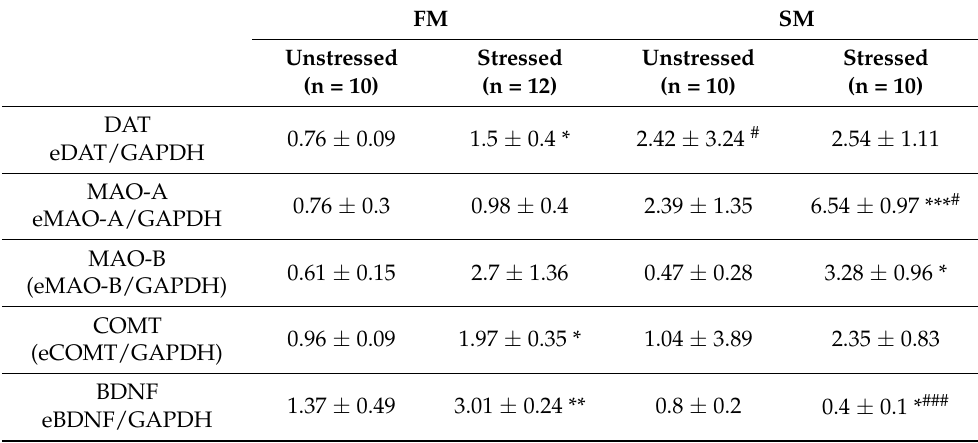
Table 2. Gene expression of hippocampal metabolic enzymes and BDNF in FMs and SMs. FM SM Unstressed Stressed Unstressed Stressed (n = 10) (n = 12) (n = 10) (n = 10) DAT 0.76 ± 0.09 1.5 ± 0.4 * 2.42 ± 3.24 # 2.54 ± 1.11 eDAT/GAPDH MAO-A 0.76 ± 0.3 0.98 ± 0.4 2.39 ± 1.35 6.54 ± 0.97 *** # eMAO-A/GAPDH MAO-B 0.61 ± 0.15 (eMAO-B/GAPDH) COMT 0.96 ± 0.09 1.97 ± 0.35 * (eCOMT/GAPDH) BDNF 0.4 ± 0.1 * eBDNF/GAPDH